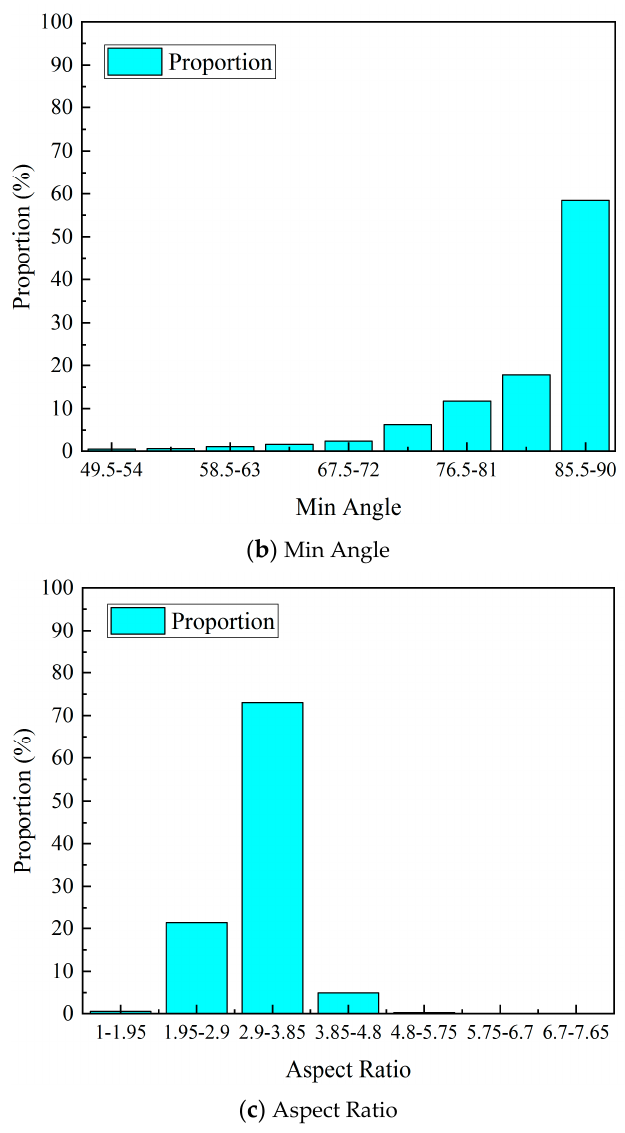
Figure 3. Results of mesh quality inspection.